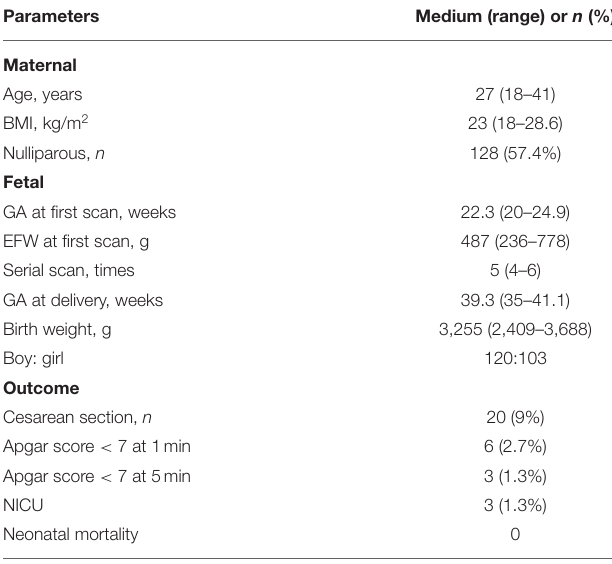
TABLE 1 | The clinical characteristics and outcome of the cohort ( n = 223).